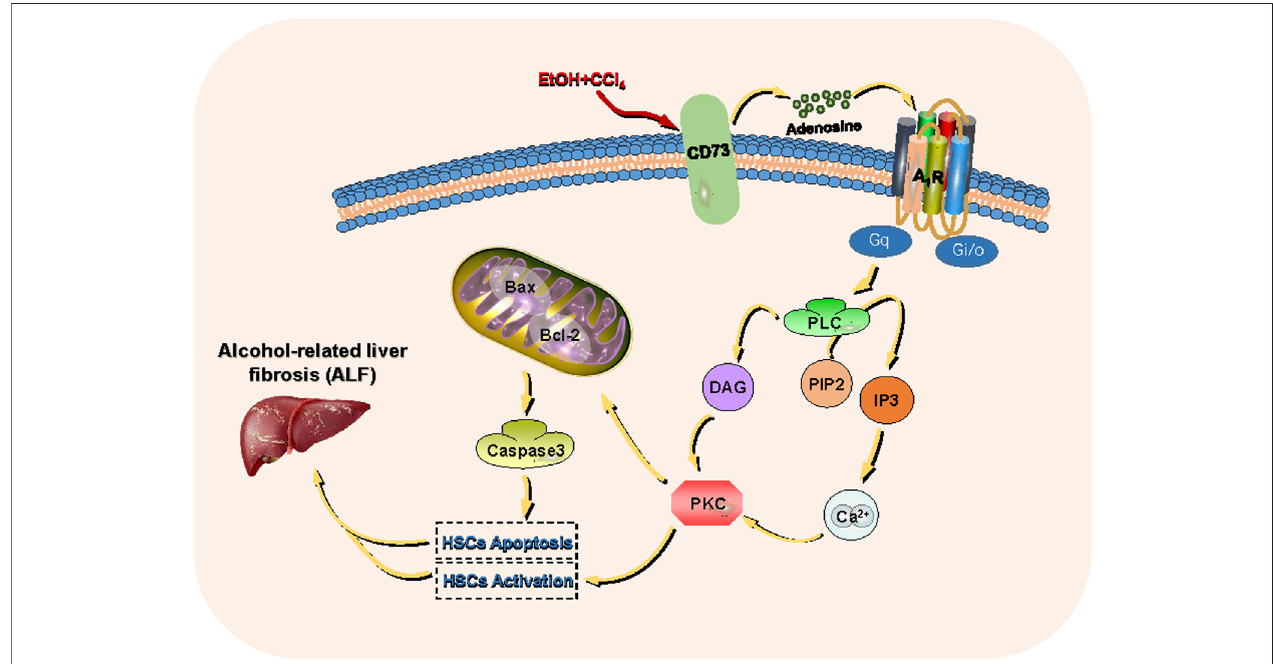
FIGURE 11 | CD73- A 1 R axis regulates the activation and apoptosis of HSCs through the PLC-IP 3 -Ca 2+ /DAG-PKC signaling pathway.